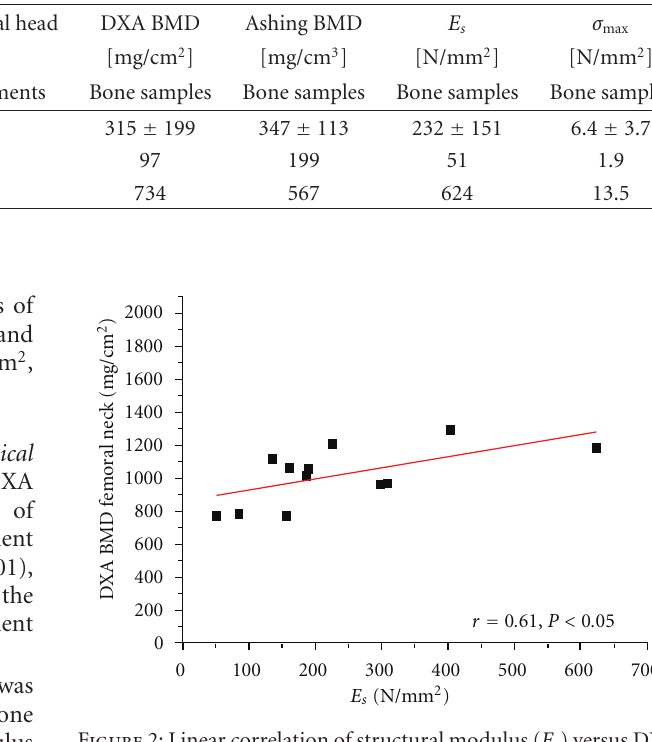
Figure 2: Linear correlation of structural modulus ( E s ) versus DXA BMD on femoral neck (standardised patient